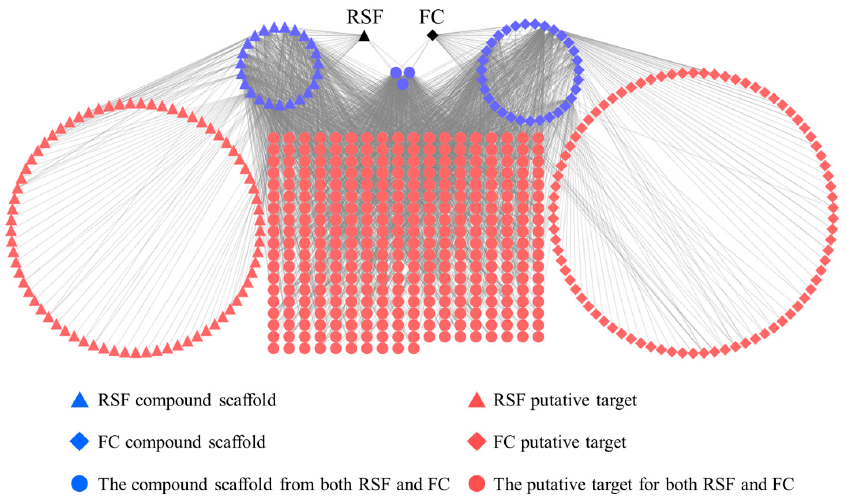
Figure 2. Herb-scaffold-target network. The black nodes represent herbs, the blue nodes represent scaffolds, and the red nodes represent putative targets. RSF, Radix Sophorae Flavescentis and FC, Fructus Cnidii .